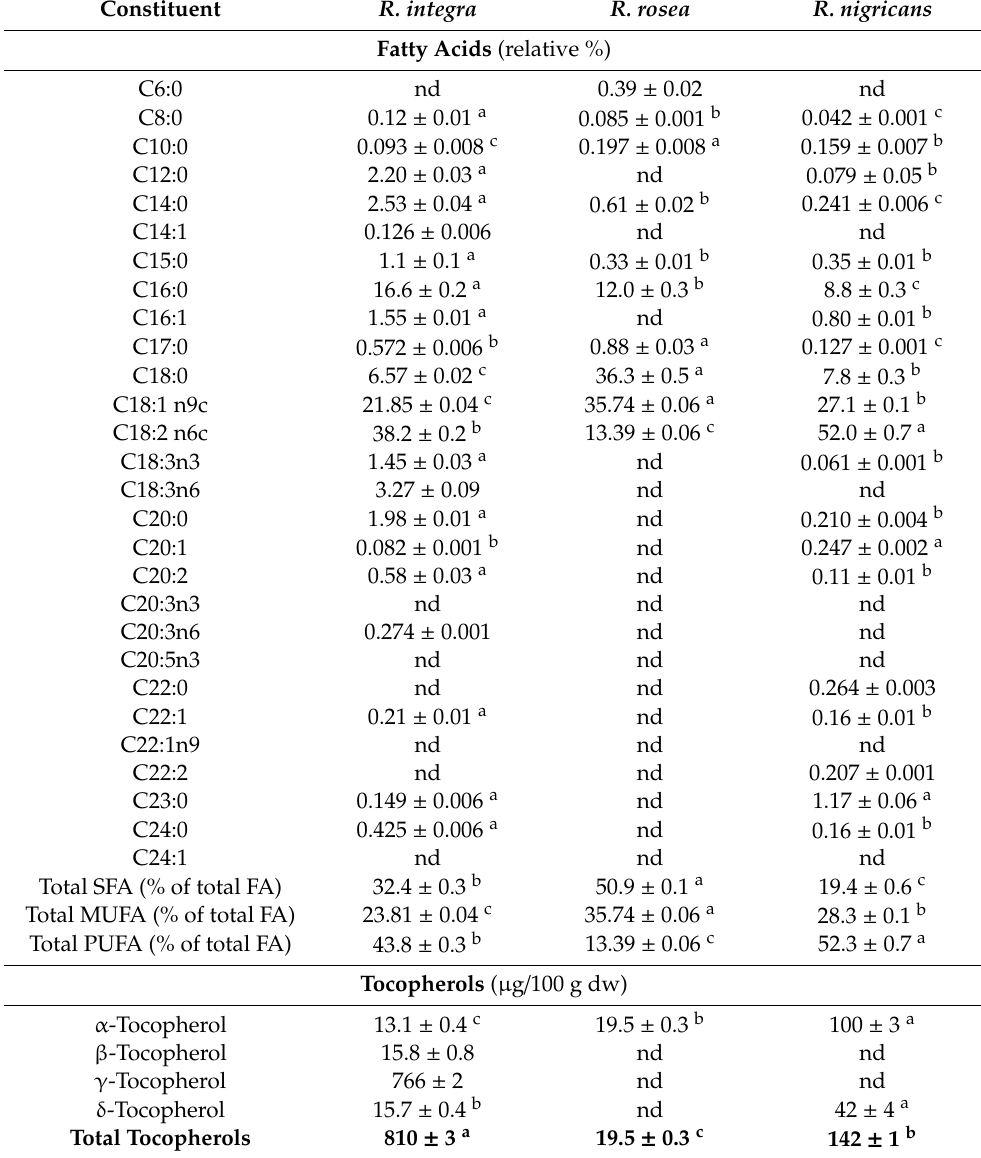
nd—not detected; Di ff erent letters in the same row indicate significant di ff erences between the means according to Tukey’s HSD test at p = 0.05; The bold indicate the total cumulative